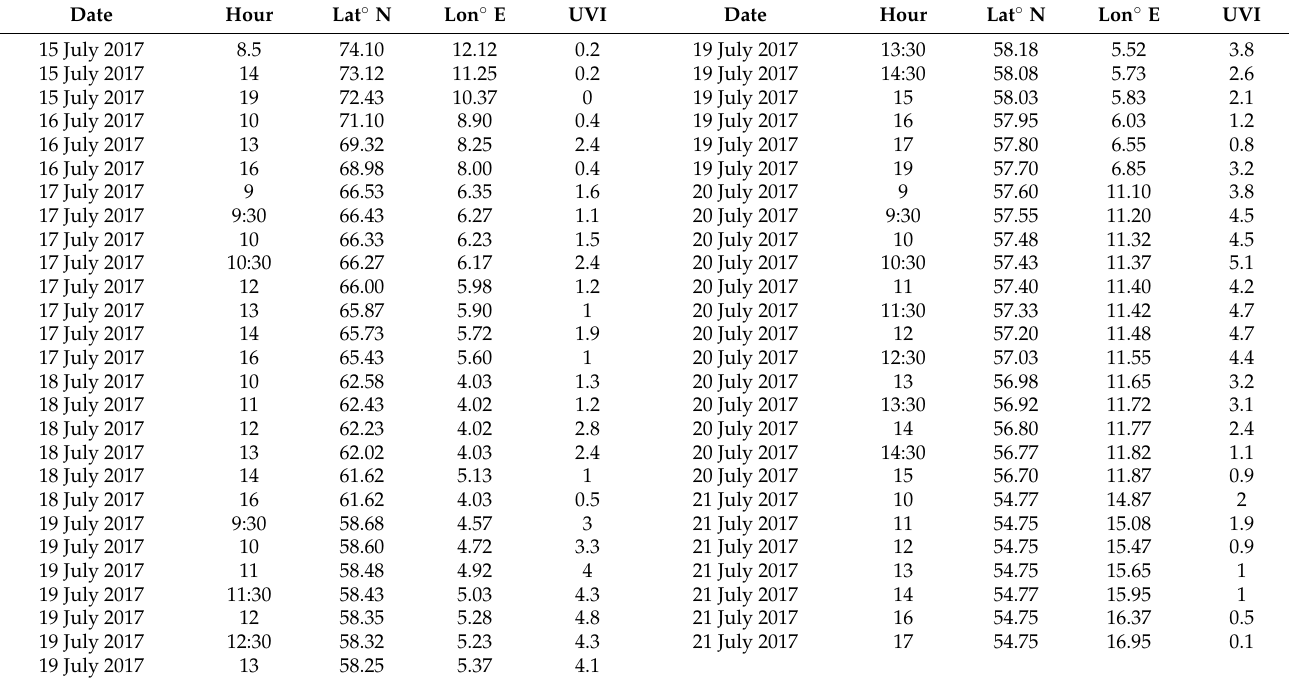
Table A3. The same as Table A1 but during the MS Horyzont II cruise from Spitsbergen to Gdynia in the period 15–21 July 2017 (days